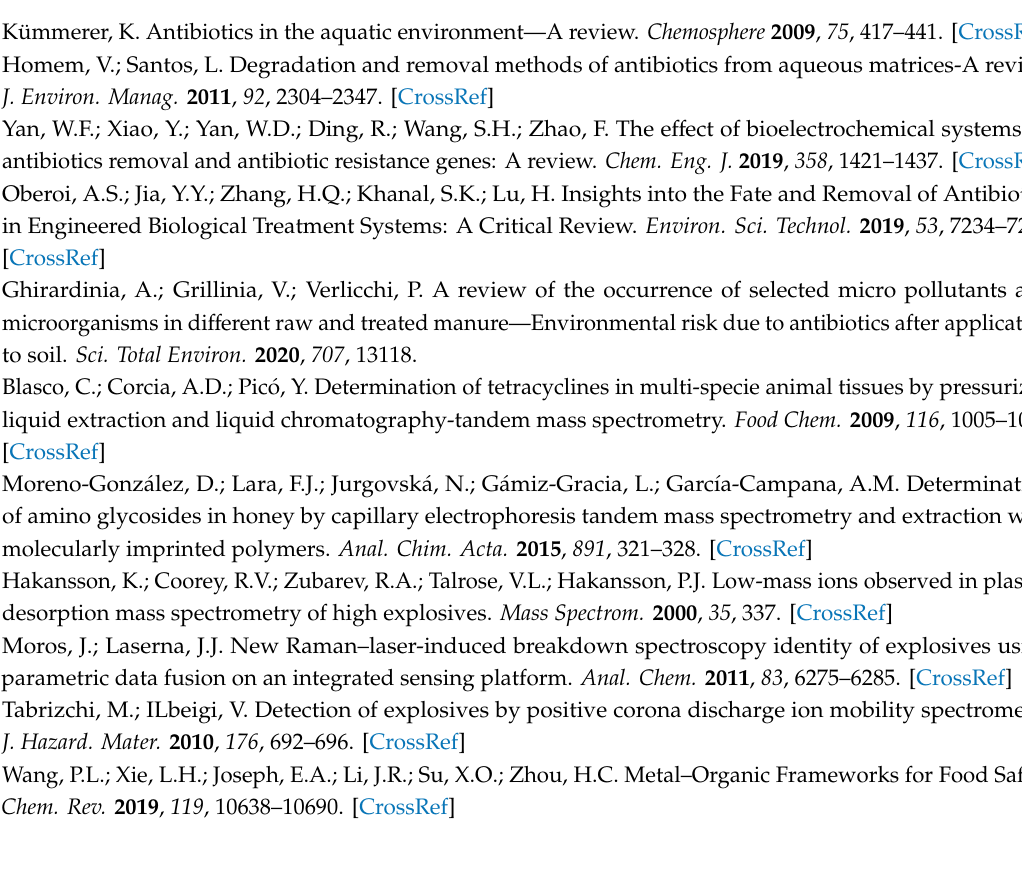
Figure S1: The binuclear terbium secondary building units (SBUs) in ZTU-5 , Figure S2: Hirshfeld surface mapped with the fingerprint plots of compound ZTU-5 , Figure S3: The X-ray di ff raction (XRD) patterns of ZTU-5 , Figure S4: The thermo gravimetric analyzer (TGA) curves of ZTU-5 , Figure S5: Dependence of χ m T and χ m − 1 for ZTU-5 , Figure S6: The solid-state excitation spectra of ZTU-5 , Figure S7: The solid-state emission spectra of ZTU-5 , Figure S8: Molecular structures of the explored nitro-antibiotics in this work, Figure S9: The linear correlation of (I 0 / I) vs. concentrations of NZF, Table S1: The selected bond distances and angles of ZTU-5 , Table S2: Bond lengths (Å) and angles ( ◦ ) of hydrogen bonds of ZTU-5